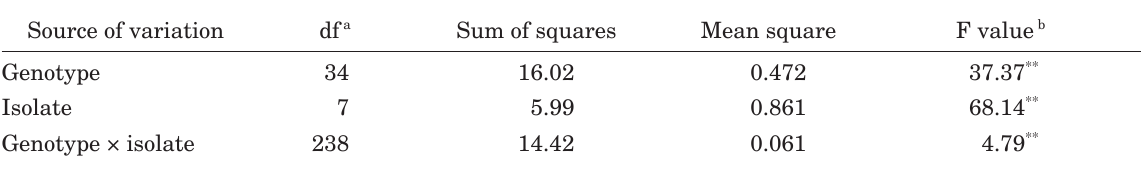
Table 1. Analysis of variance for disease severity in sunflower genotypes infected by eight Sclerotinia sclerotiorum isolates in controlled conditions. Coefficient of variation =